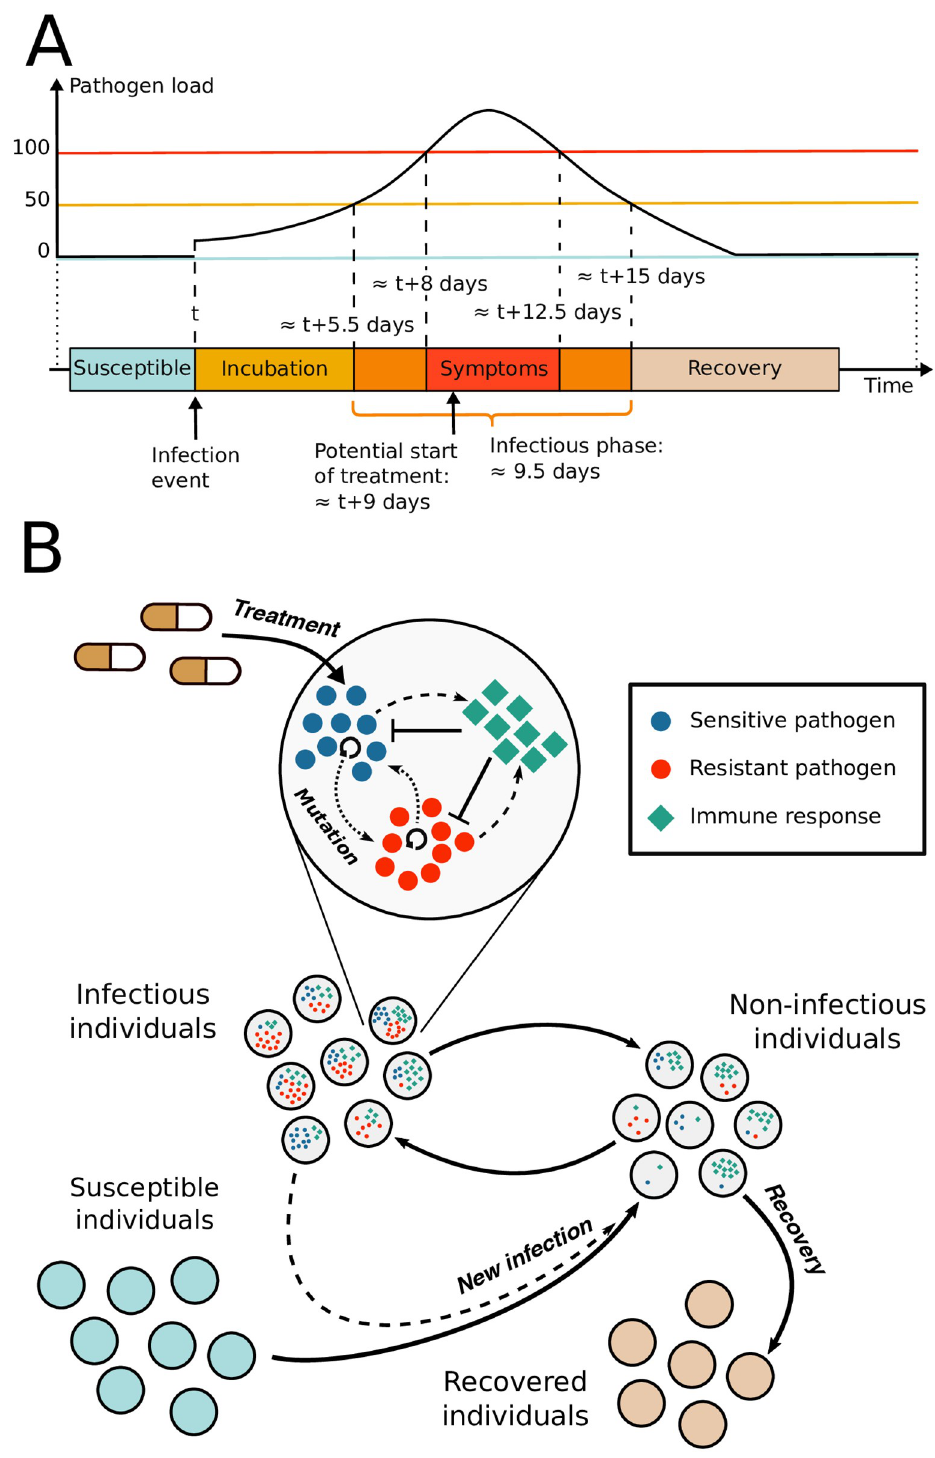
Fig 1. Nested model of an acute infectious disease. (A) Average timeline of the infection for a non-treated individual. The host’s transition from one phase to the other is determined by the pathogen load. (B) Diagram of the nested model. Prior to infection, individuals are susceptible. For infected individuals, the pathogen load defines if an individual is infectious or non-infectious. Once the pathogen load has dropped to zero, individuals are recovered and have aquired life-long